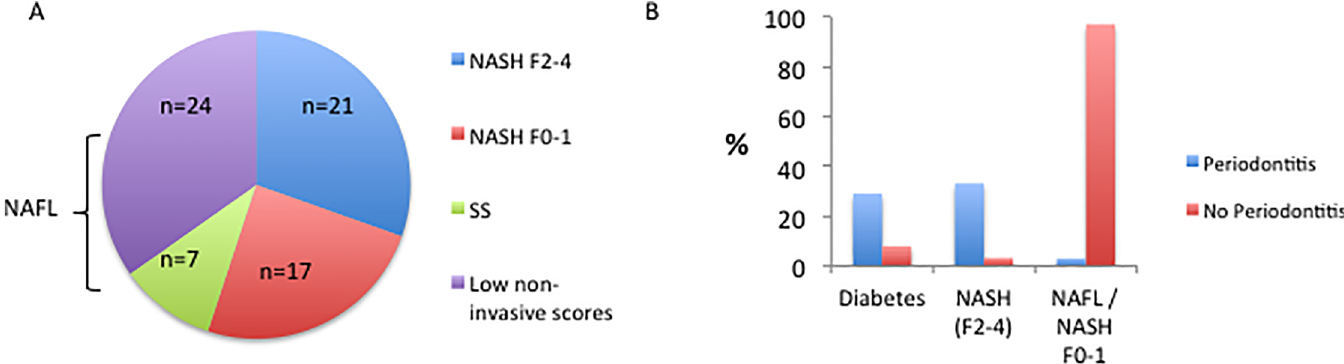
Fig 1. Prospective (London) cohort A. stage of liver disease and B. prevalenceof periodontitis in patients with diabetes, NASH (F2-4) or NAFLD/NASH (F0- 1).